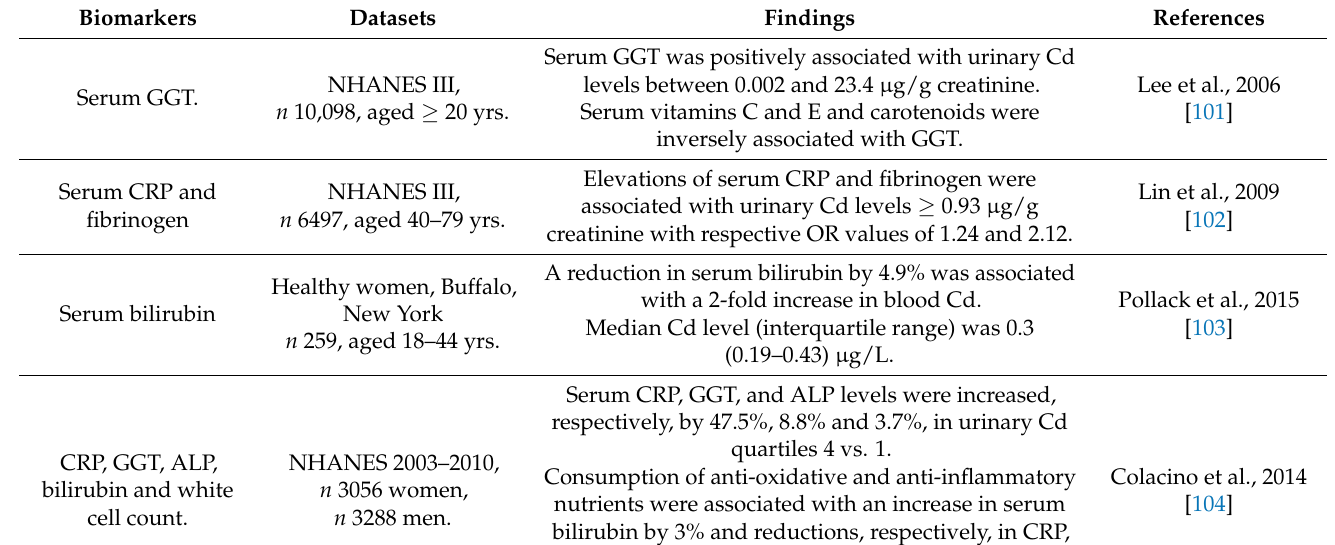
Table 2. Cadmium-induced oxidative stress and